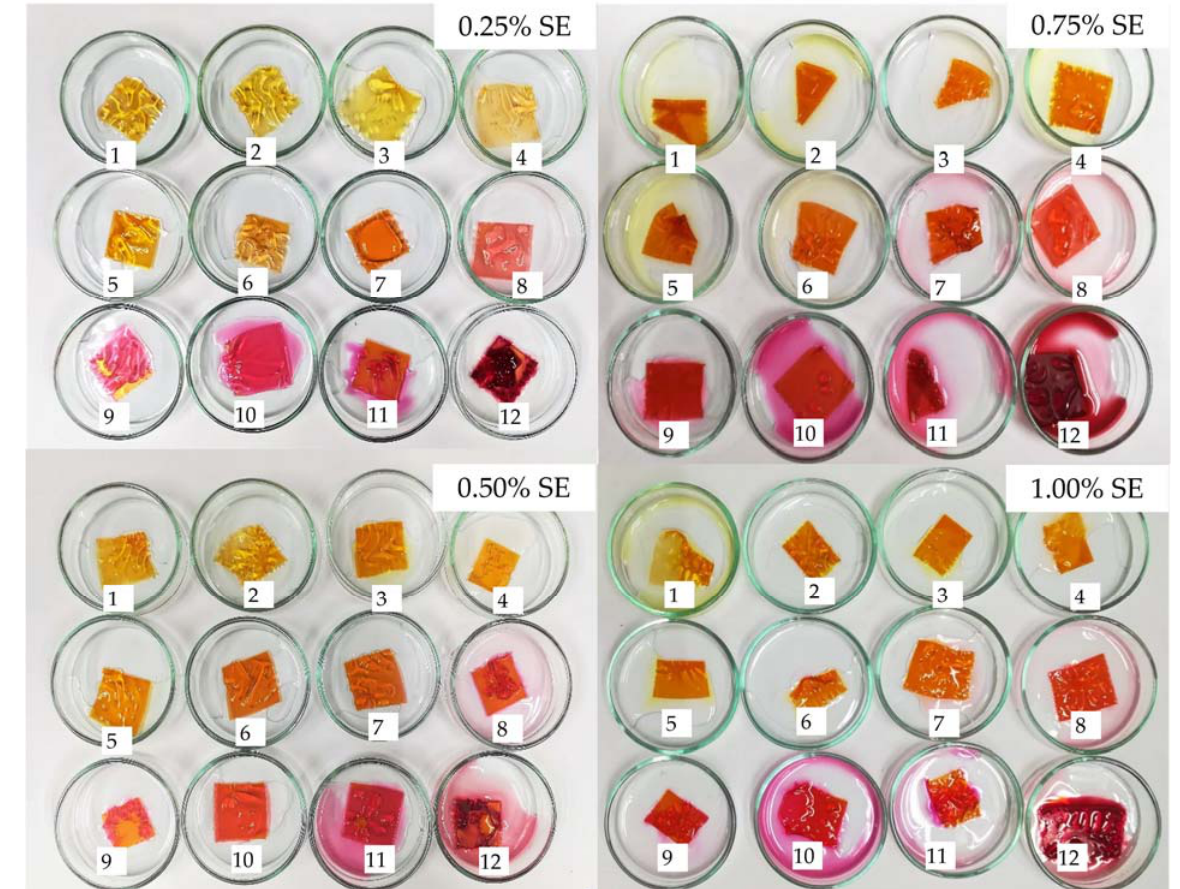
Figure 1 . pH sensitivity of gelatin films incorporated with sappan heartwood extract at different concentrations . SE : sappan heartwood extract . The number donated the pH level .